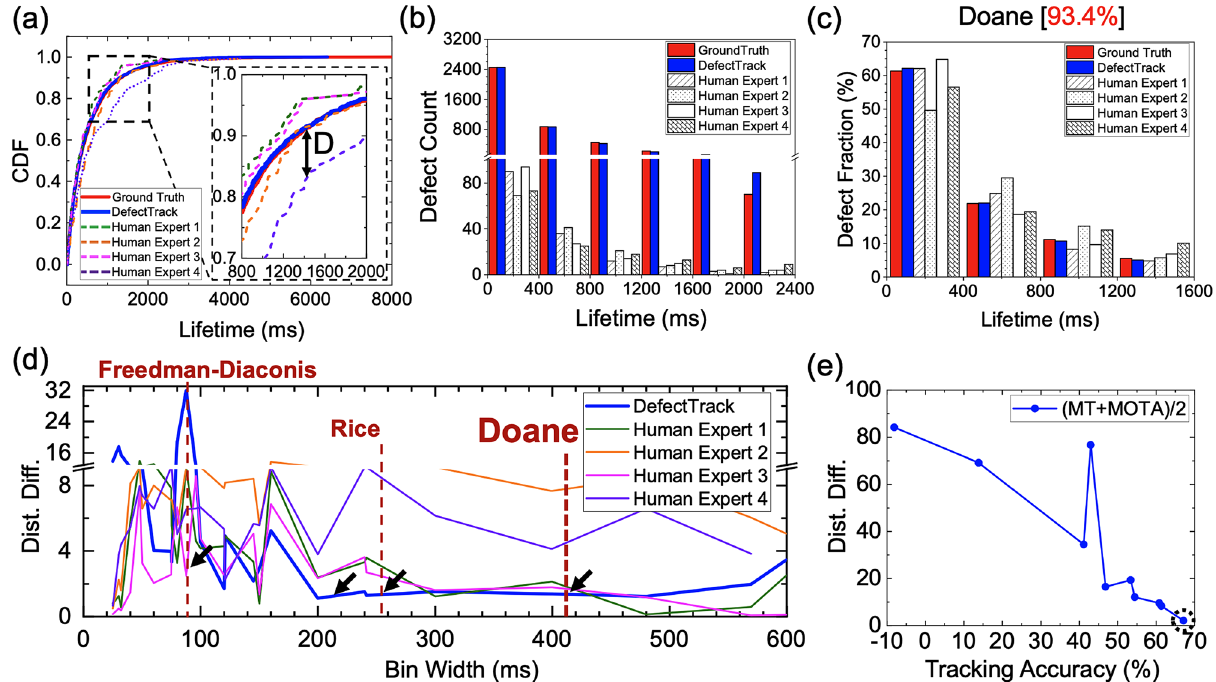
Figure 7. Comparison of the defect lifetime distribution prediction by DefectTrack and by Human Experts with the ground truth. ( a ) The cumulative distribution functions (CDF) of defect lifetime distribution of ground truth, as predicted by DefectTrack, and four human expert measurements. ( b ) Histogram showing the true lifetime distribution, DefectTrack prediction, and Human Expert measurements. ( c ) Normalized lifetime histogram. 93.4% of ground truth was included in the comparison after lifetime cutoffs. ( d ) The calculated distribution-difference (Dist. Diff.) for different bin widths (Fig. S7 and Table S2). The black arrow points to the bin widths at which DefectTrack has the lowest distribution-difference. Note the distribution-difference comparison can only be made for each bin width, and not across bin widths. ( e ) The correlation between the calculated distribution-difference (Dist. Diff.) on the y-axis and the MOT tracking performance evaluation on the